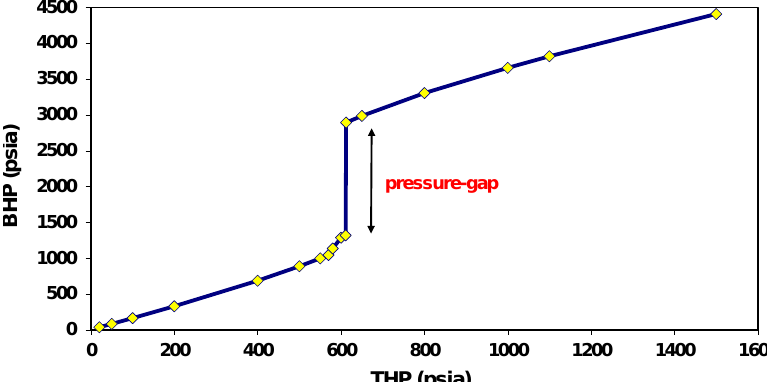
Figure 7. BHP versus THP shown under static conditions where a pressure gap